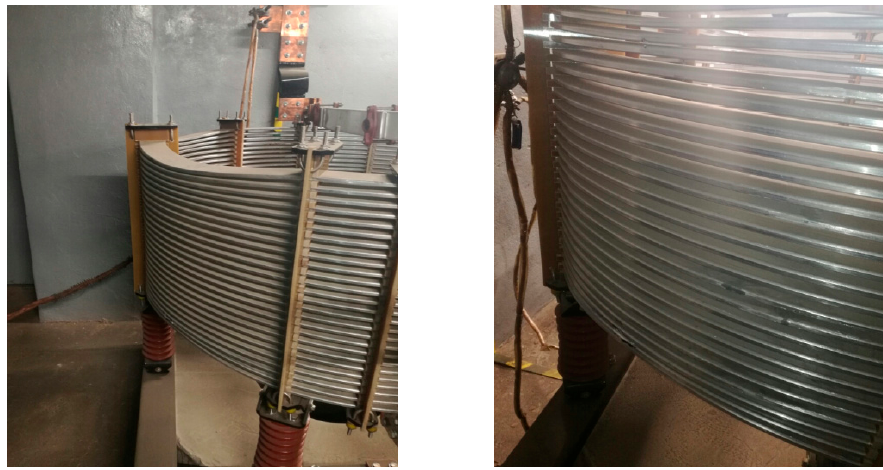
Figure 4. A faulty coil of the intersection current-limiting reactor SR2.